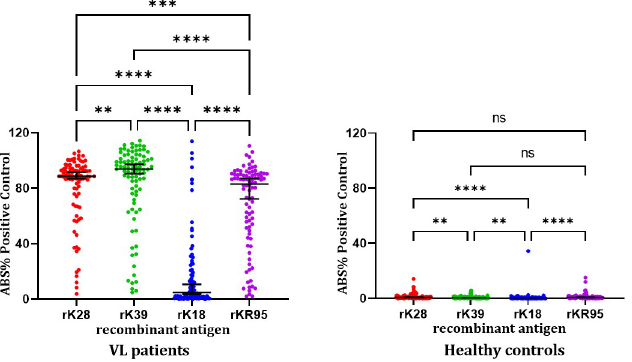
Fig 3. Percentage of absorbance of the positive standard ( ABS% Positive ) obtained by ELISA using recombinant antigens in sera from VL patients and healthy controls (Panel 1). The horizontal black lines represent the median ABS% Positive Control values with a 95% confidence interval. Friedman test: p < 0.0001 (VL patients and Healthy controls). Dunn’s multiple comparisons test: VL patients: �� —p = 0.0049; ��� —p = 0.0002; ���� —p < 0.0001. Healthy controls: �� —p = 0.0044 (rK28 x rK39) and p = 0.0013 (rK18 x rK39); ���� — < 0.0001; ns—p = 0.0517 (rK39 x rKR95) and p > 0.9999 (rK28 x rKR95).